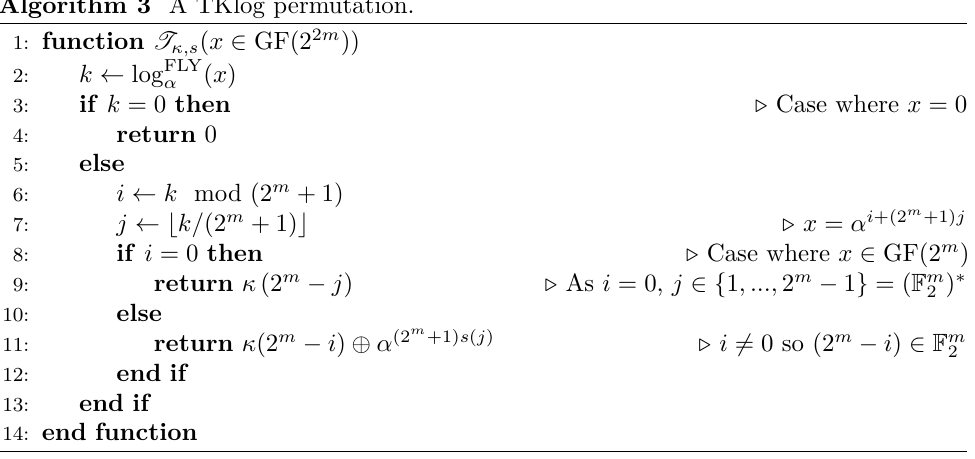
Algorithm 3 A TKlog permutation.